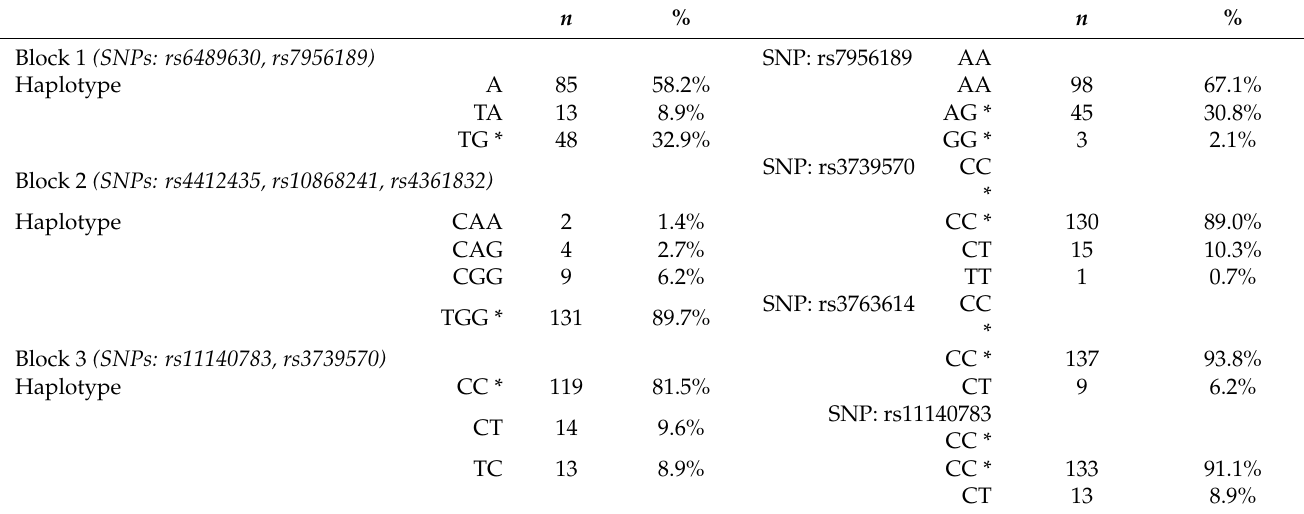
Table 2. Distribution of the genetic variables in the study ( n =